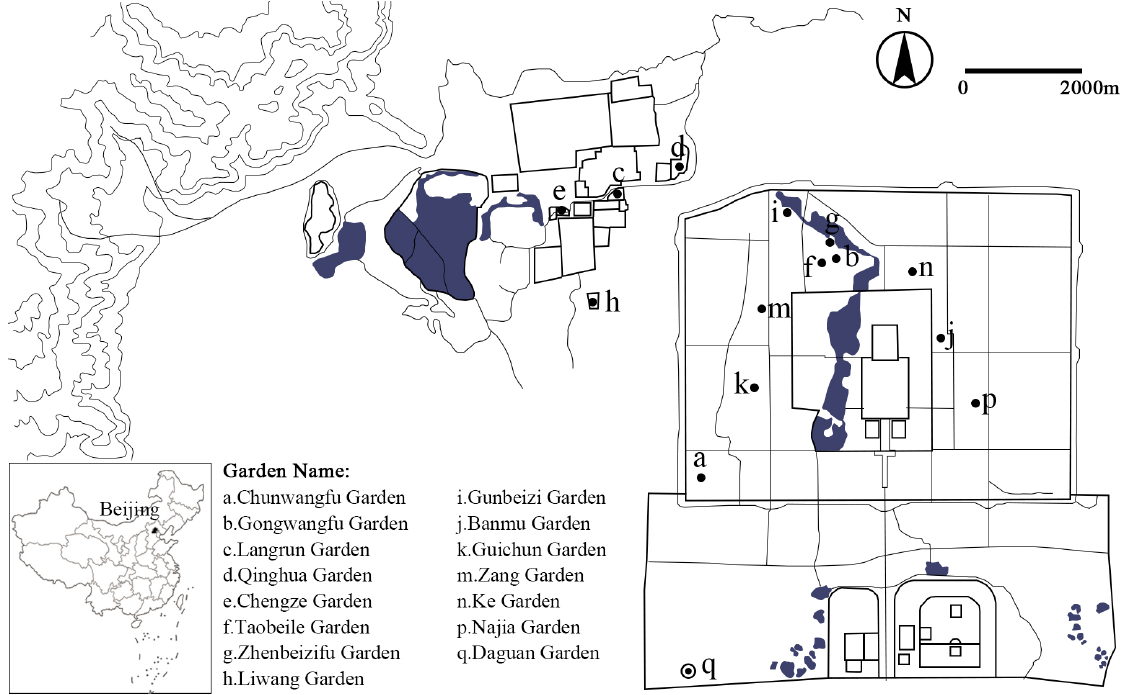
Figure 2. Distribution of research objects in Beijing.